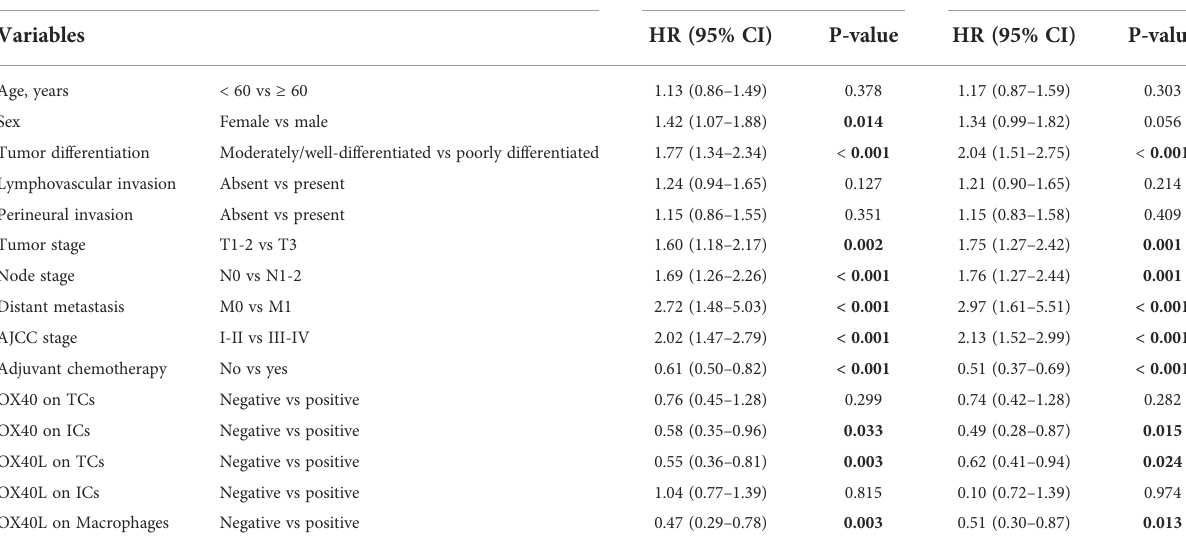
TABLE 1 Univariate analysis of factors potentially associated with progression-free survival and disease-speci fi c survival. Progression-free survival Disease-speci fi c